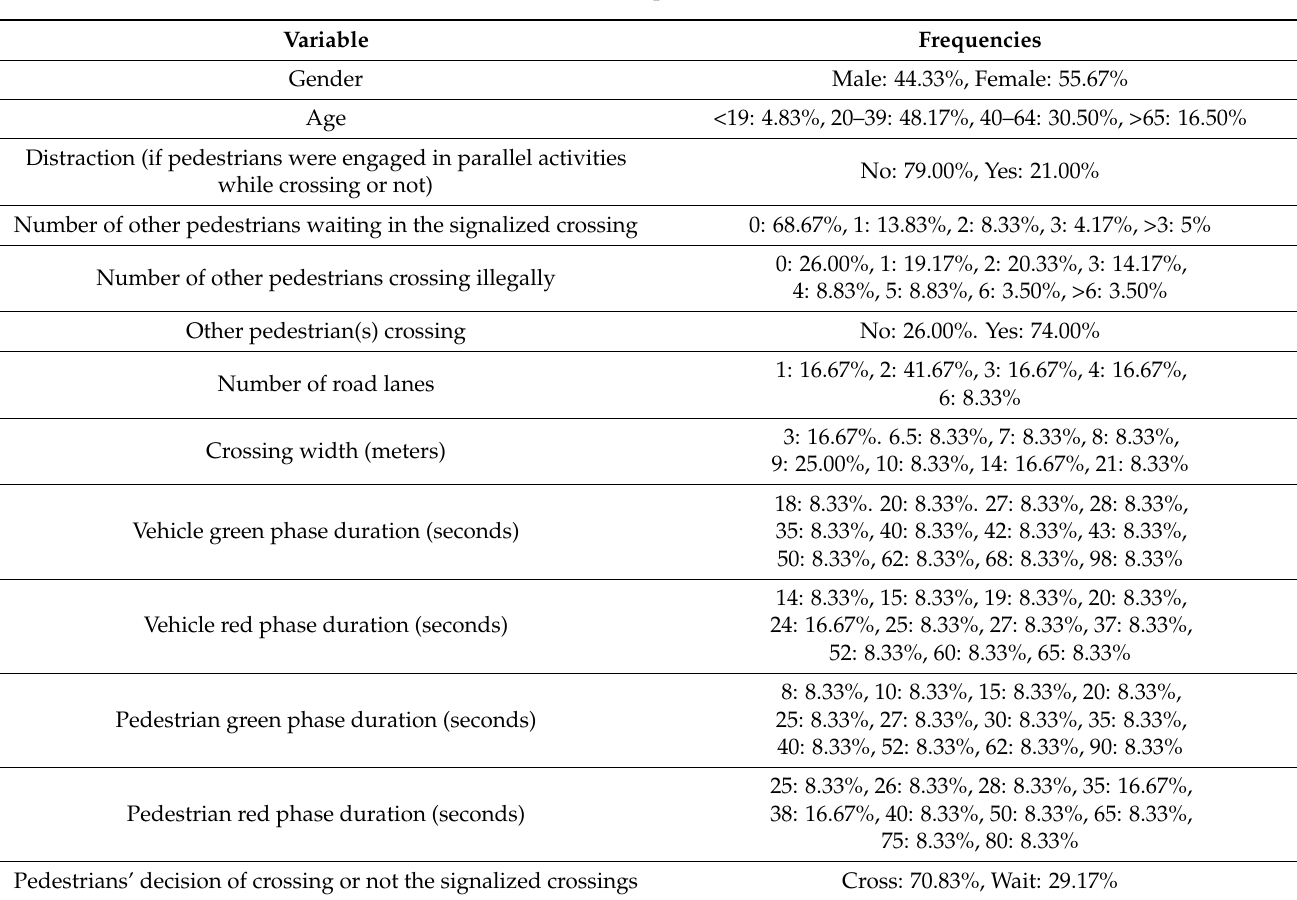
Table 2. Descriptive